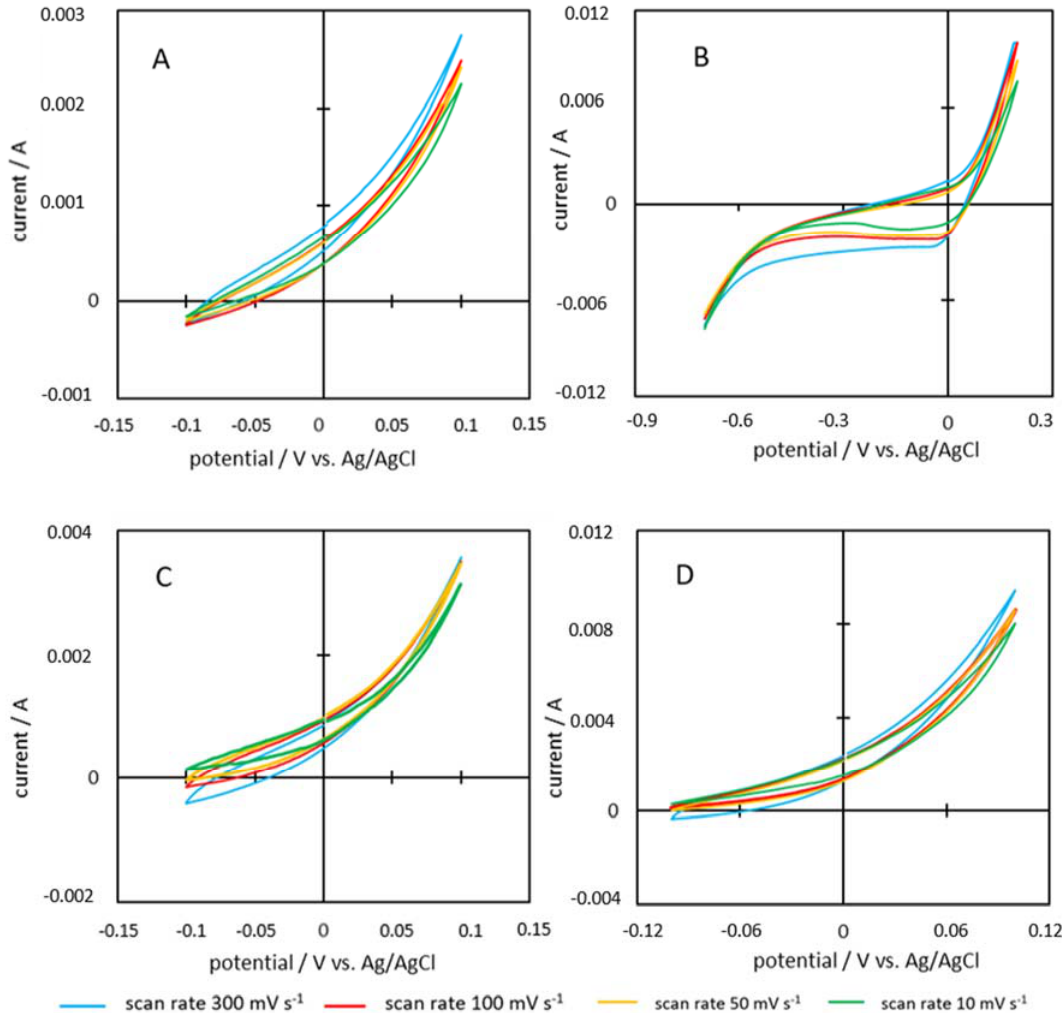
Figure 13. Cyclovoltamograms of the samples ( A ) P900 ‐ 200 ‐ 2, ( B ) P900 ‐ 200 ‐ 5, ( C ) P900 ‐ 220 ‐ 2, and ( D ) P900 ‐ 220 ‐ 5.